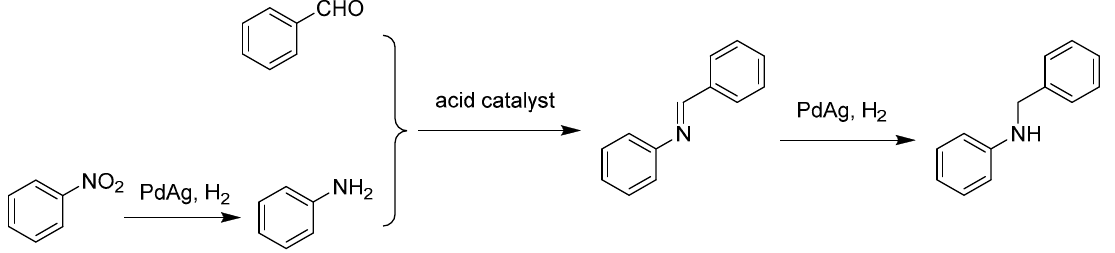
Figure 10. Synthesis of secondary arylamines through hydrogenation of nitrobenzene and reductive amination of benzaldehyde.